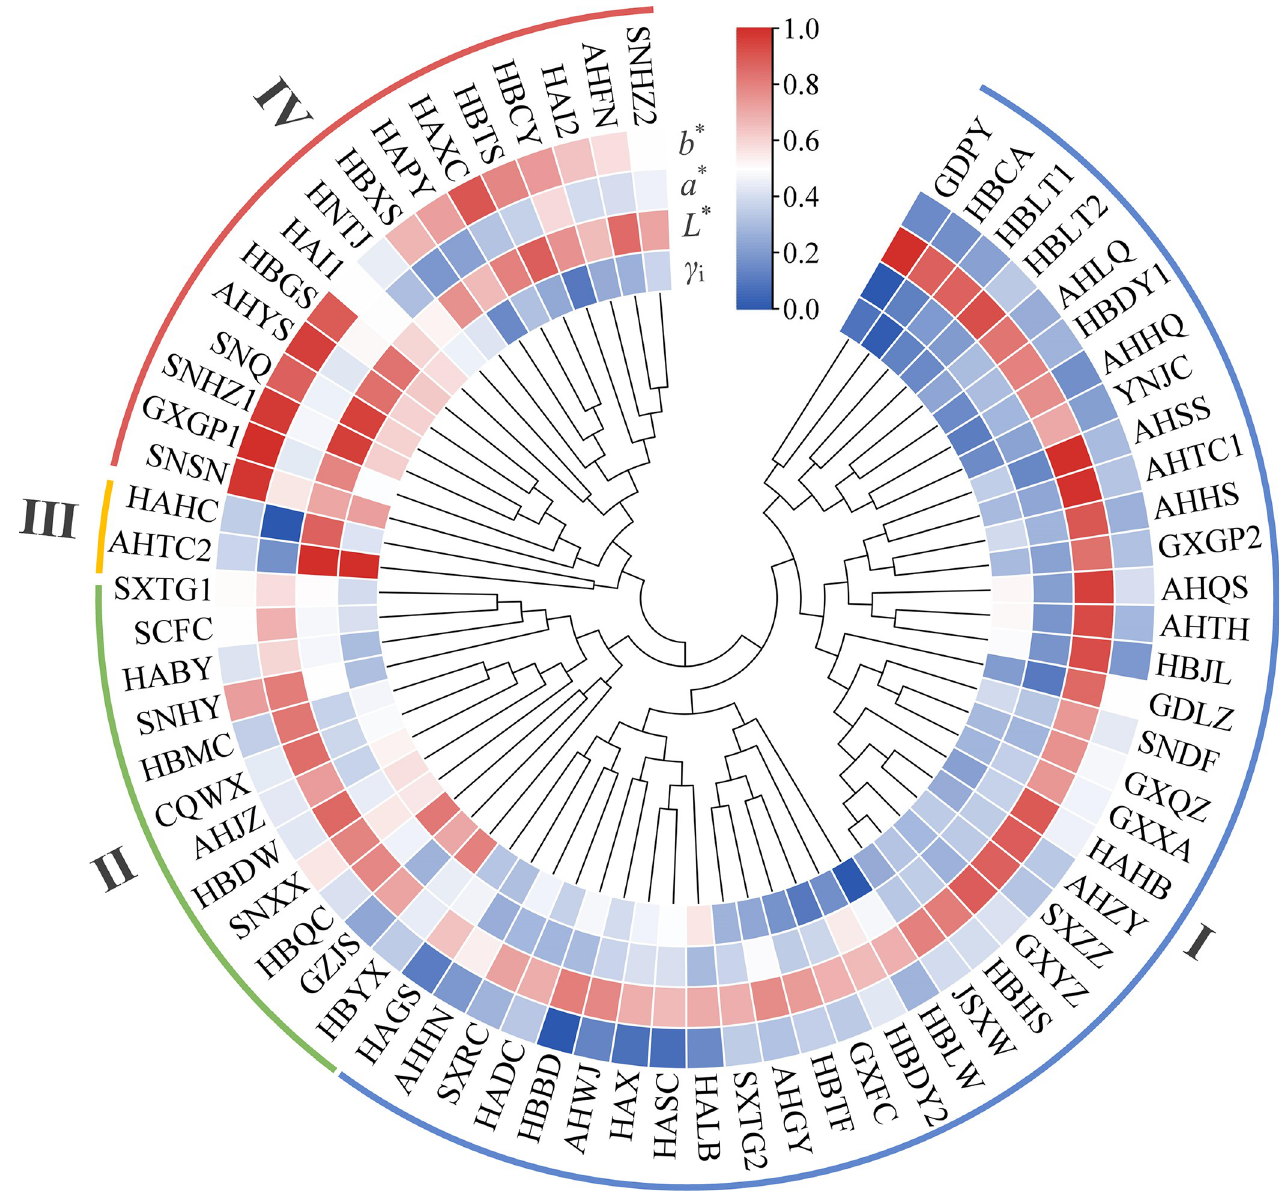
Fig 3. Cluster analysis heat map of γ i and color parameters of